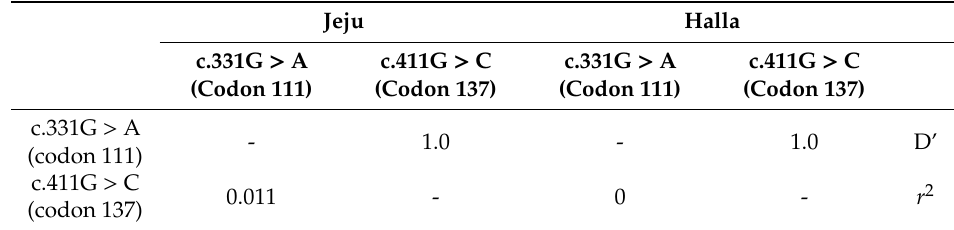
Table 5. Linkage disequilibrium (LD) between two polymorphisms in the PRND gene in Jeju and Halla horses.